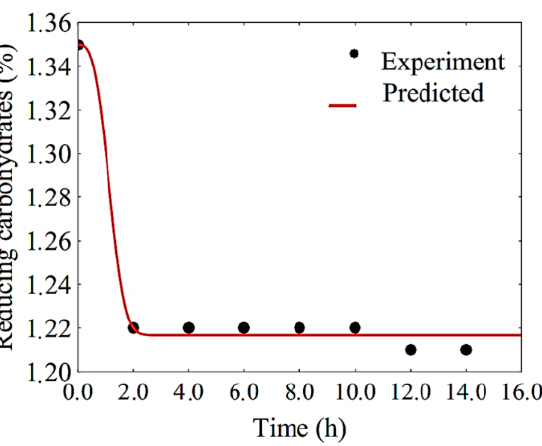
in Figure 6, which corresponds to the period of exponential growth of cell concentration in the filmogenic solution.